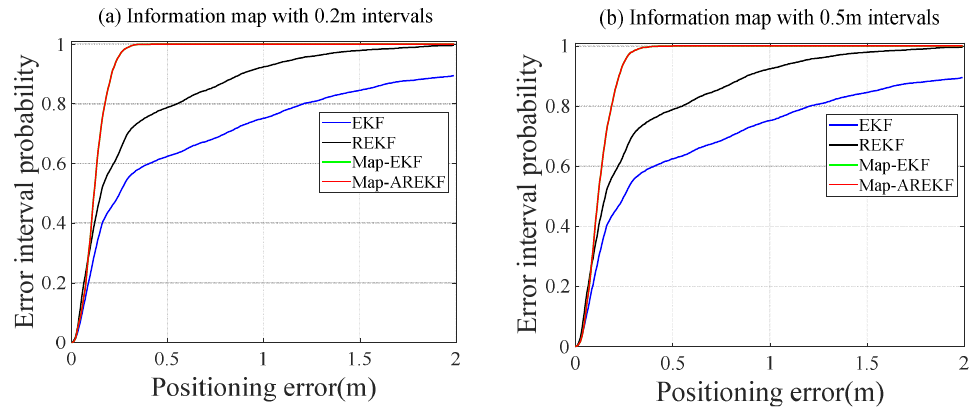
Figure 26. Probability statistics of algorithm localization error for Experiment 3.